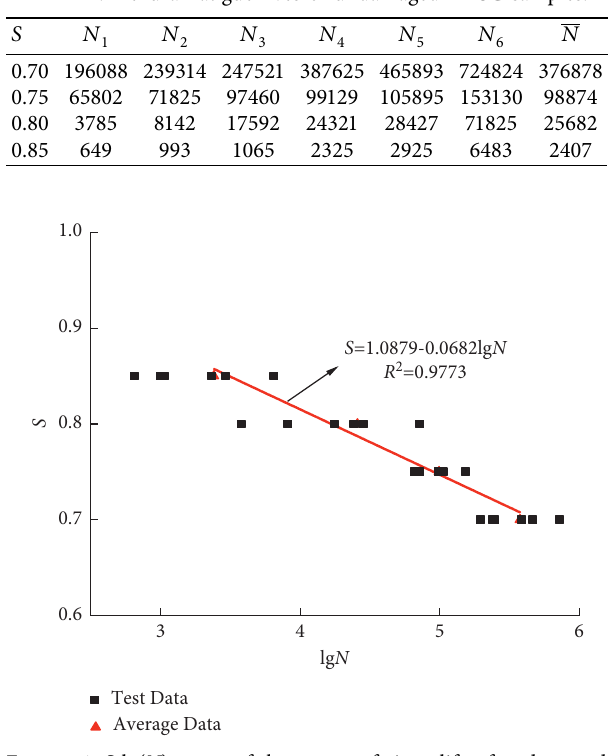
Figure 4: S- lg( N ) curve of the average fatigue life of undamaged AASC.